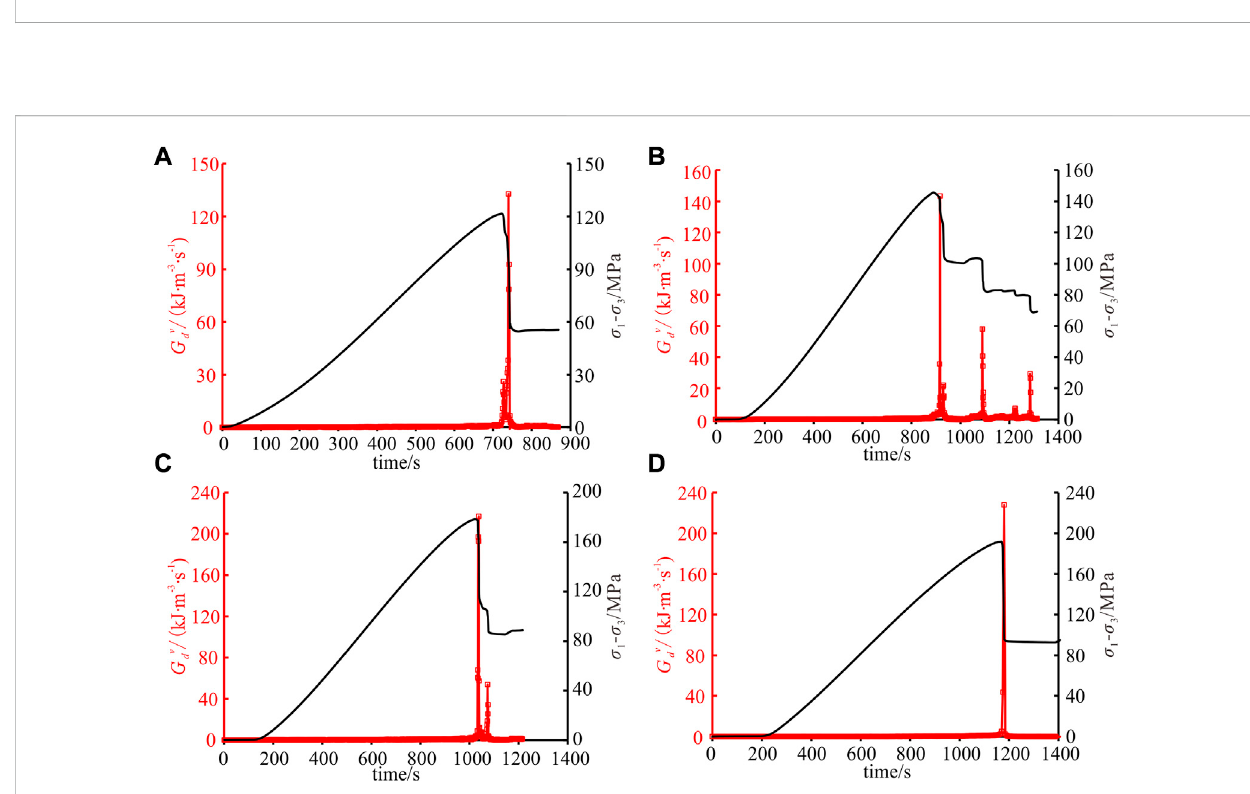
FIGURE 10 Evolution of energy dissipation rate under CTC. (A) σ 3 = 5 MPa. (B) σ 3 = 10 MPa. (C) σ 3 = 15 MPa. (D) σ 3 = 20 MPa.